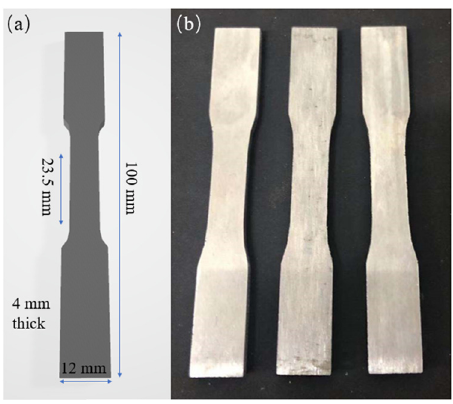
Figure 6: ( a ) CAD showing tensile bar ’ s dimension; ( b ) LPBF - pro - duced CNTs/AlSi10Mg nanocomposites tensile samples after machining.